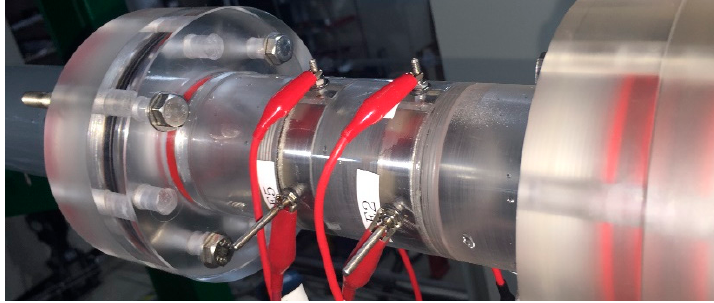
Figure 6. Schematic diagram of the air-water two-phase flow loop.